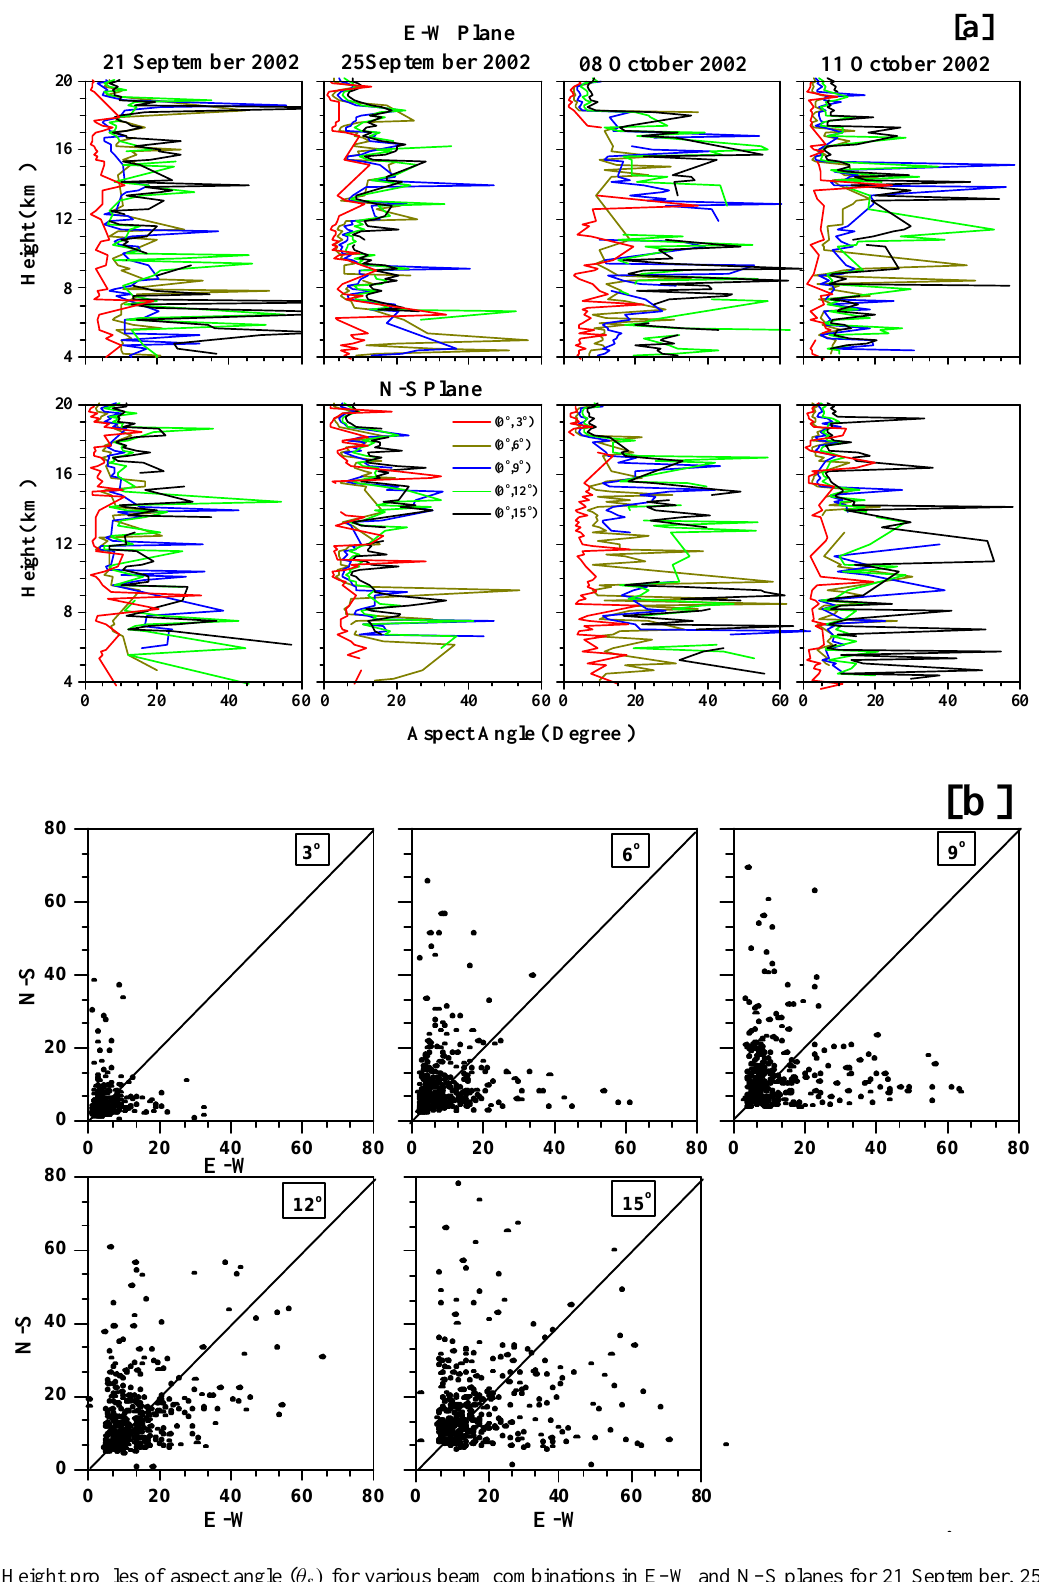
Fig. 4. ( a ) Height profiles of aspect angle ( θ s ) for various beam combinations in E–W and N–S planes for 21 September, 25 September, 8 October and 11 October 2002. Each of these beam combinations use zenith beam as reference. ( b ) Aspect sensitivity in two planes (E–W and N-S) in the form of scatter plots for different beam zenith